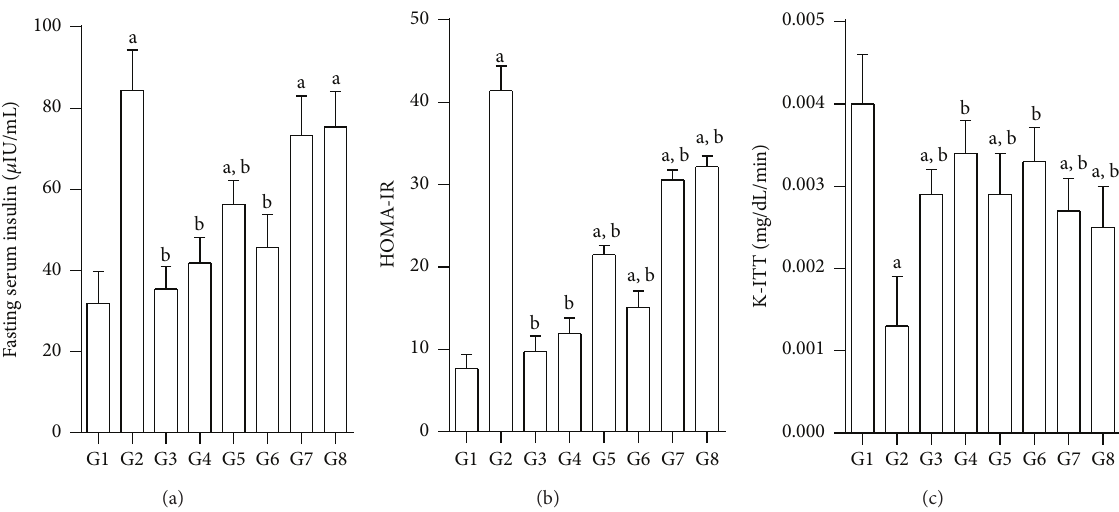
Figure 5: Effect of test compounds on serum insulin, HOMA-IR, and insulin tolerance in nicotinamide, STZ induced diabetic rats; all values mean ± SEM ( 𝑛 = 6 ); (a) fasting serum insulin ( 𝜇 IU/mL); (b) HOMA-IR; and (c) K-ITT (mg/dL/min); G1: normal control; G2: diabetic control (nicotinamide + STZ); G3: diabetic + glibenclamide (2.5 mg/kg); G4: diabetic + quercetin (10mg/kg); G5: diabetic + JY-1; G6: diabetic + JY-2; G7: diabetic + JY-3; and G8: diabetic + JY-4; (test compounds at optimised dose of 80 mg/kg); a 𝑃 < 0.05 compared to normal rats (G1), b 𝑃 < 0.05 compared to diabetic rats (G2) (one-way ANOVA followed by Tukey’s post-hoc test).